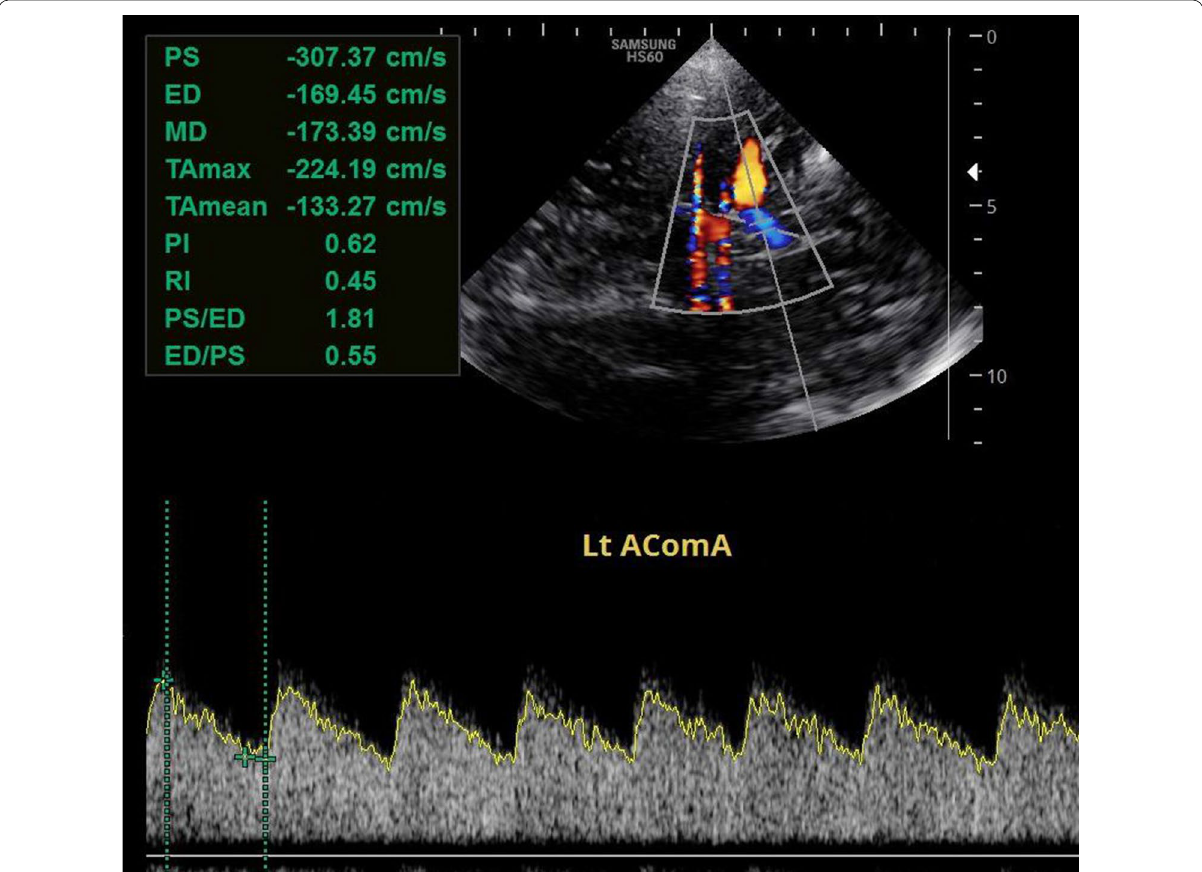
Fig. 1 Transcranial Doppler for 7 years old female patient who never transfused showing the PSV within the distal ICA on the left side to be 307 cm/s and the TAMAX to be 224 cm/s (more than 200 cm/s) indicating the presence of high stroke